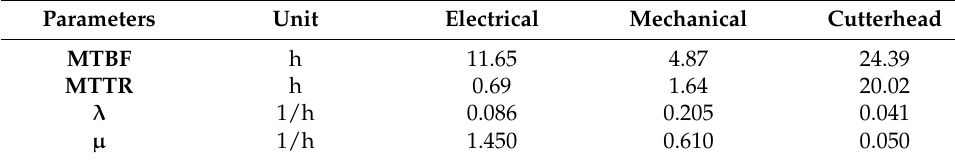
Table 2. Parameter values of the EPBM used in Line 1.